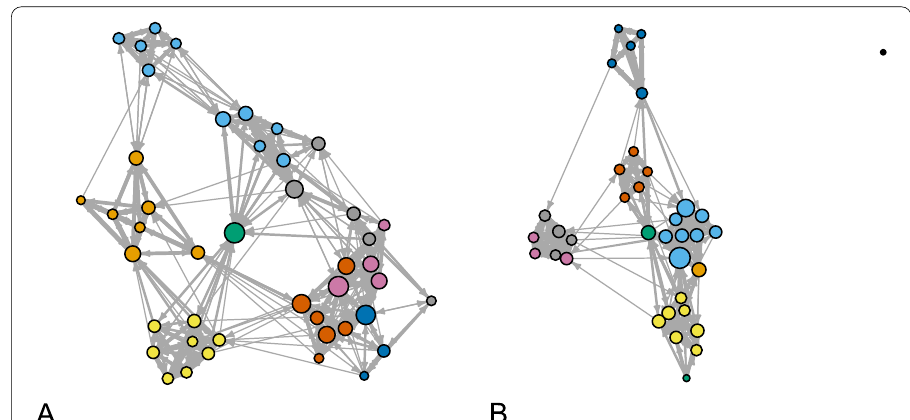
Fig. 21 Aggregate weighted networks for Fall 2015 (left) and Spring 2016 (right), with nodes sized by in-degree and edge thickness scaled by weight. Node colors show the CONCOR block assignments using all four exam networks as